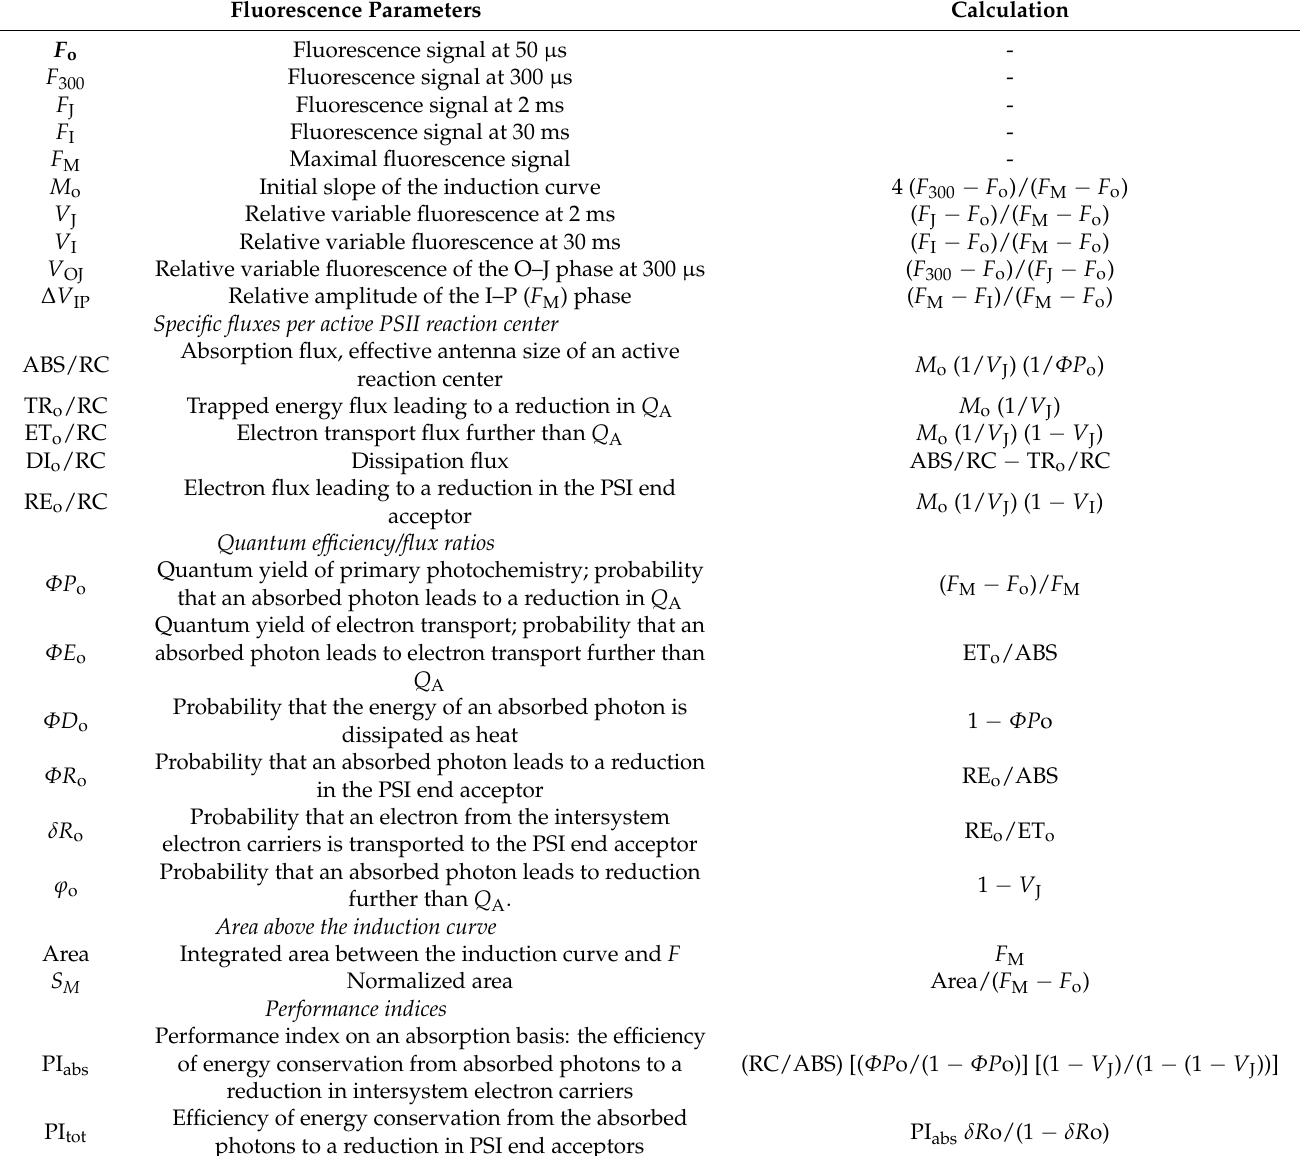
Table 1. Definitions and explanations of selected chlorophyll fluorescence OJIP parameters in this study. The parameters are derived from the literatures